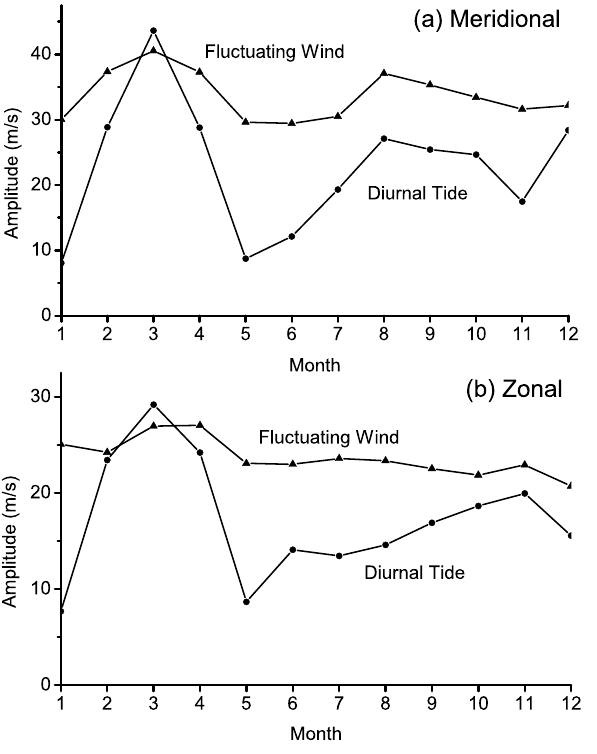
Fig. 5. As for Fig. 3 but for Santa Maria.